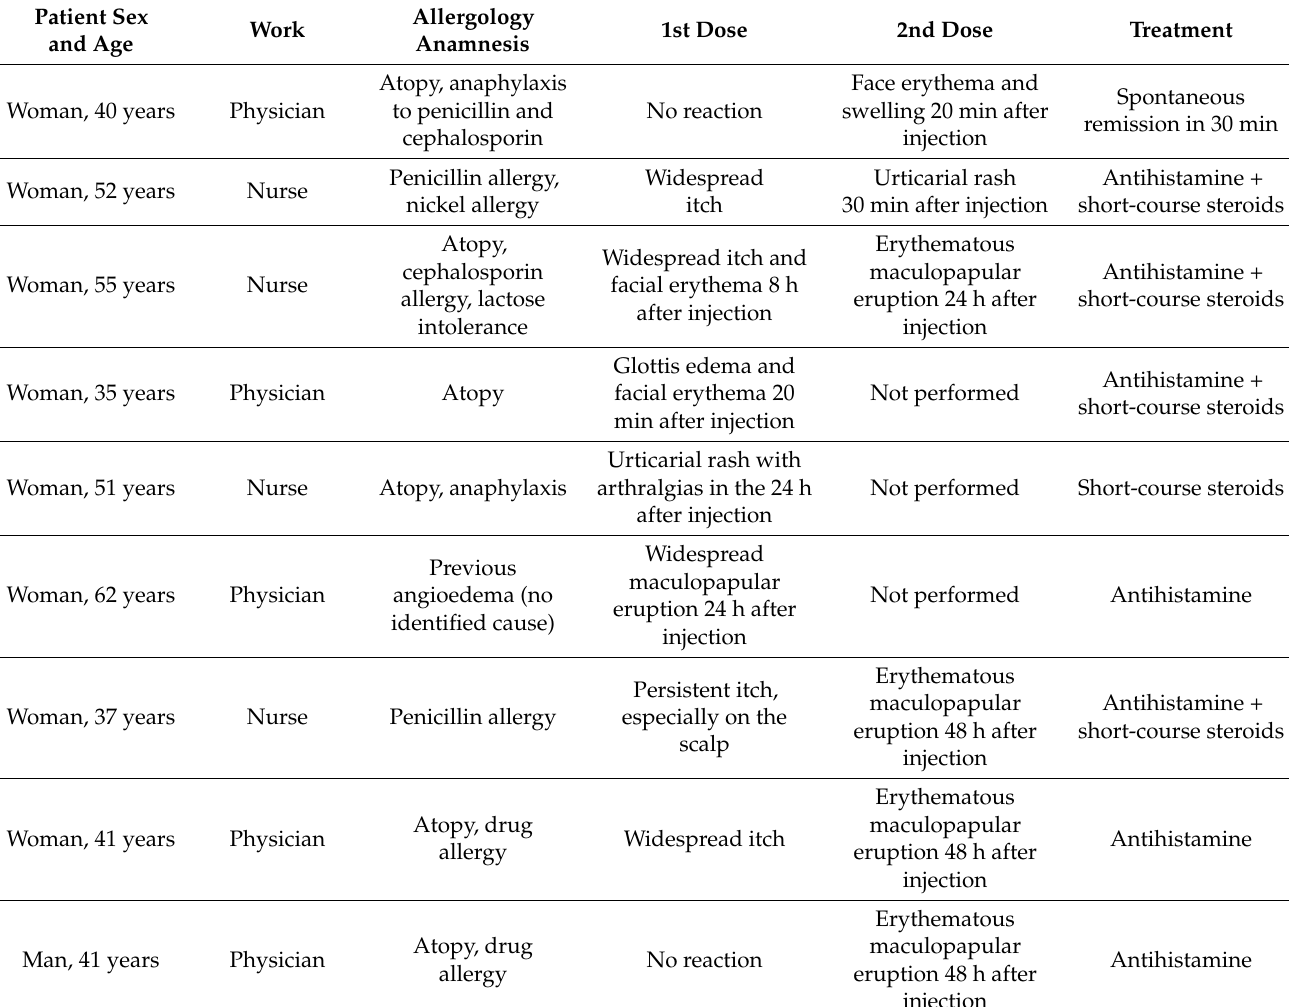
Table 1. Patients’ data and experienced cutaneous adverse reactions to Pfizer-BioNTech